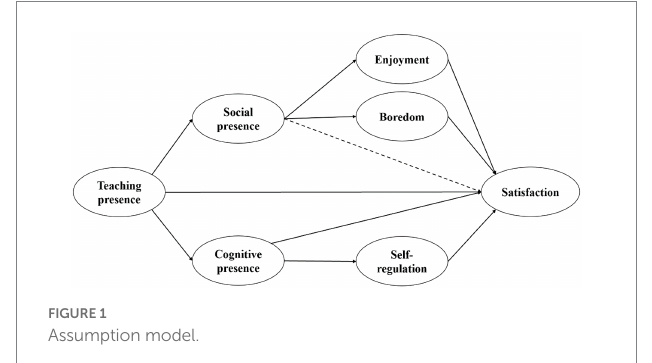
FIGURE 1 Assumption model.